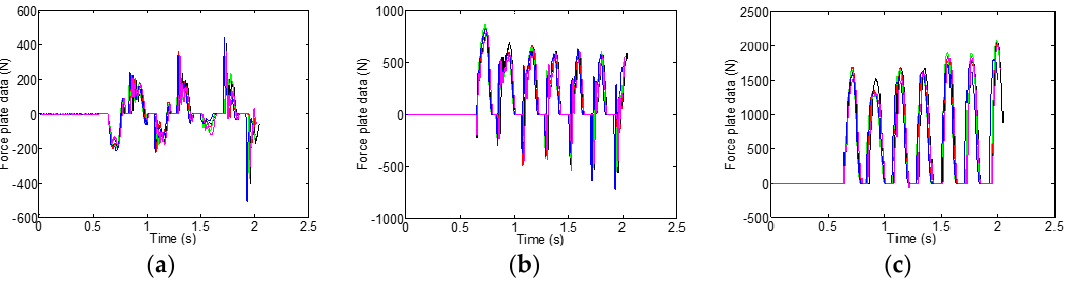
Figure 1. Ground reaction force profiles for the first seven foot strikes for all five trials from participant two. ( a ) x component, medio-lateral axis ( b ) y component, anterior-posterior axis ( c ) z component, vertical axis.